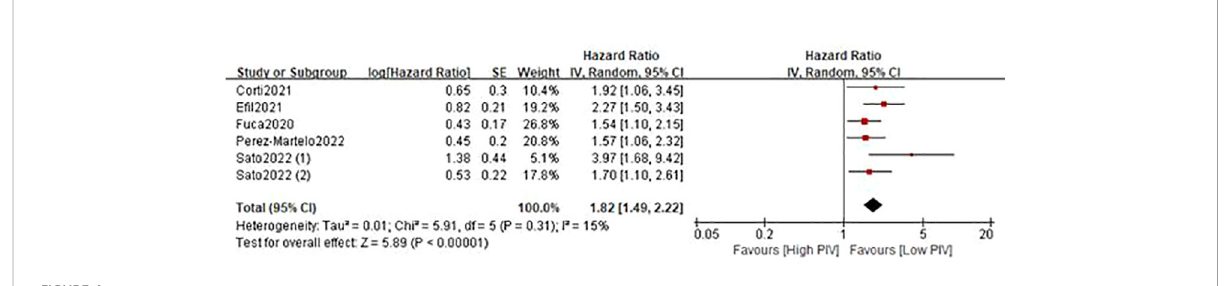
FIGURE 4 Forest plot accessing the relationship between PIV and